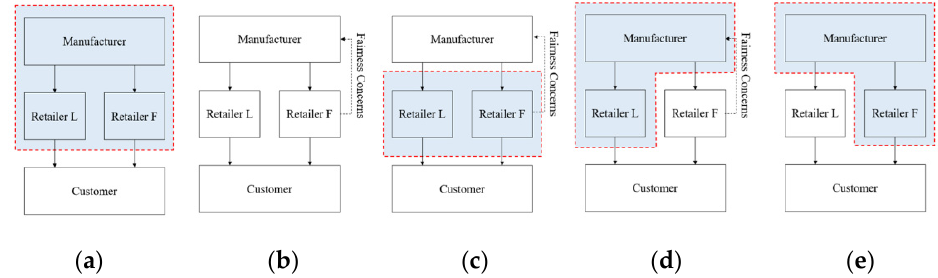
Figure 1. The cooperative, non ‐ cooperative, and partial ‐ cooperative models of the two ‐ echelon CLSC consisting of one manufacturer and two retailers are: ( a ) Model CC; ( b ) Model DC; ( c ) Model LF; ( d ) Model ML; and ( e ) Model MF.